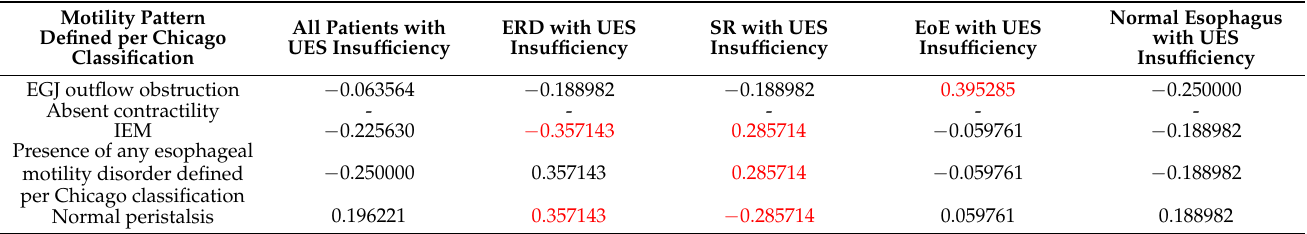
Table 7. Spearman’s rank correlation coefficients between UES insufficiency and motility pattern defined per Chicago classification in patients with ERD, SR, EoE and normal esophagus in EGD and histopathology. Significant—in red. Motility Pattern Defined per Chicago